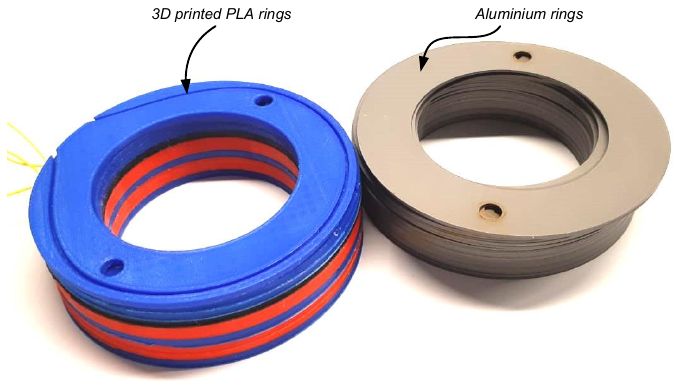
Figure 4. Printed PLA rings next to original Aluminium rings.